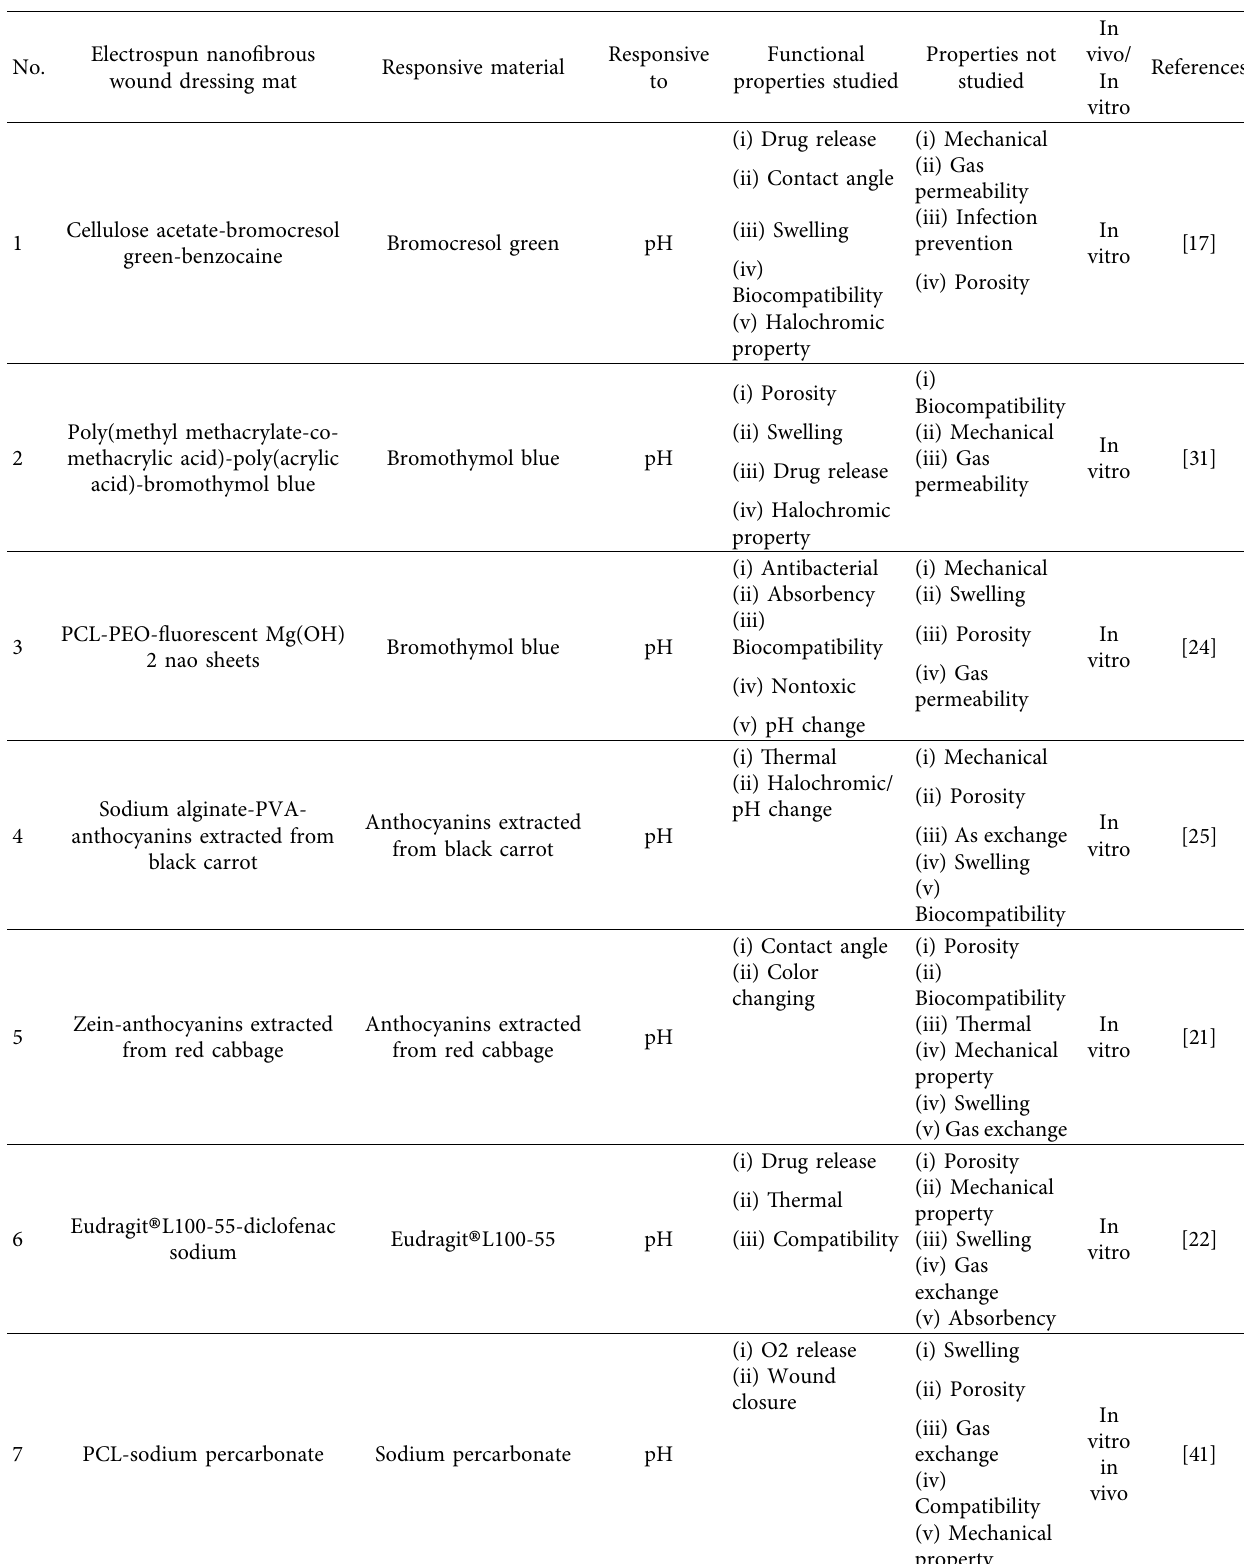
Table 2: Responsive smart electrospun nanofibrous wound dressing